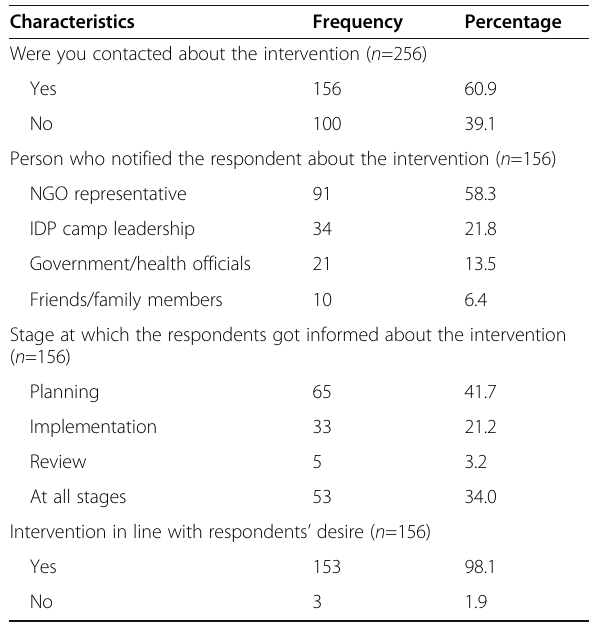
Table 4 Beneficiaries consultation prior to commencement